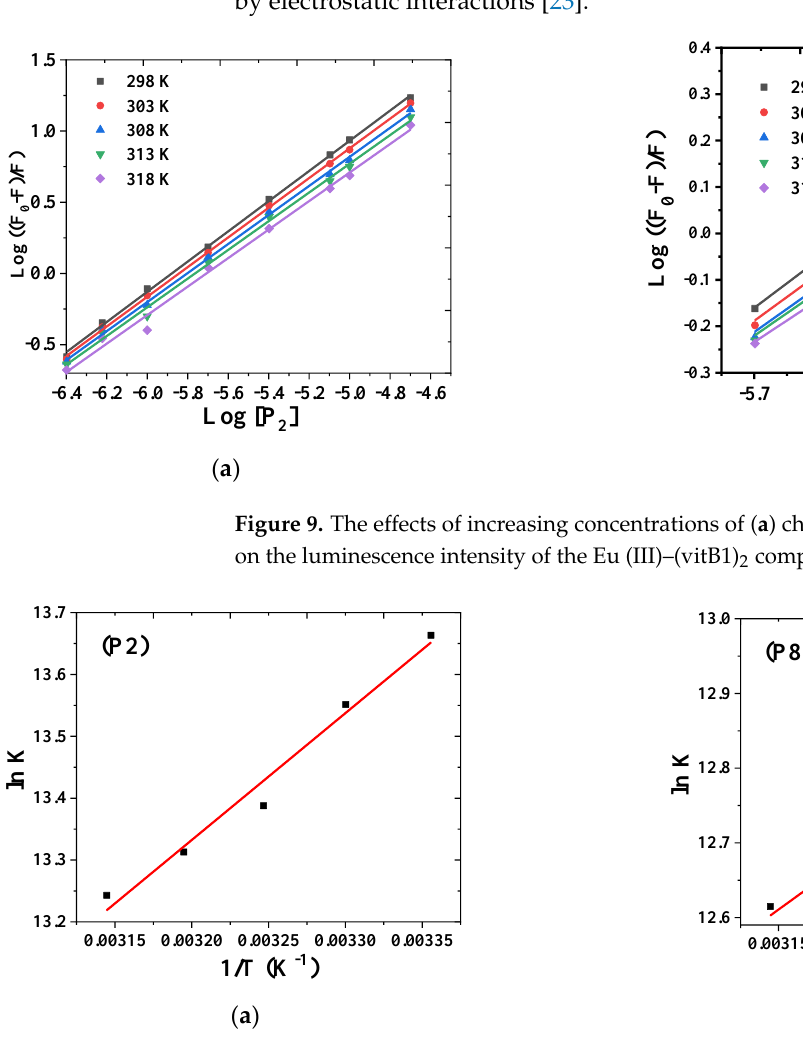
Figure 10. Van ’t Hoff plots for the interaction between the Eu (III) – (vitB1) 2 probe, and chlorfen- vinphos (P2) and malathion (P8) in methanol.